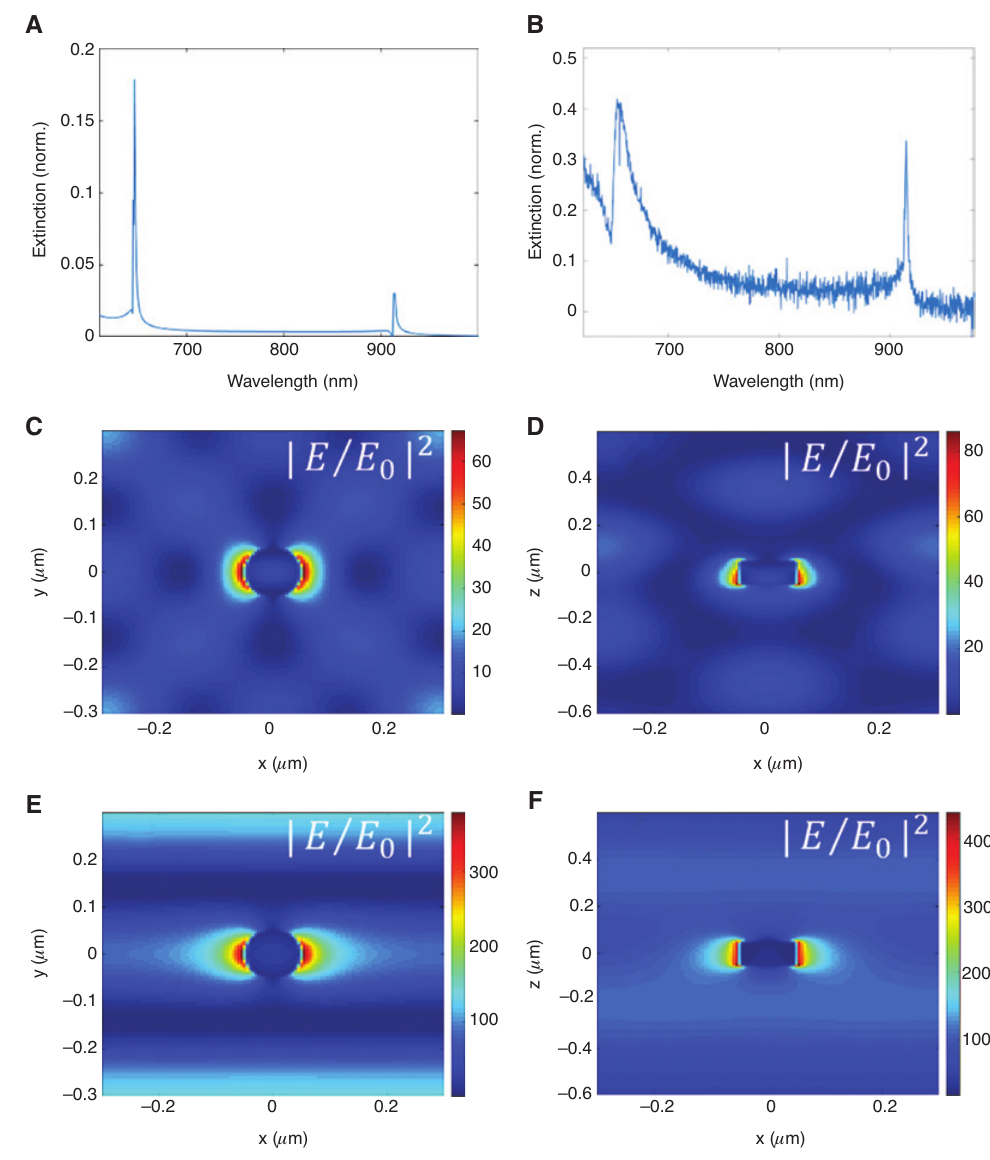
Figure 4: FDTD simulation results for amorphous silicon. (A) Simulated transmission spectrum and (B) measured spectra at k 646 nm crosscuts in the xy-plane (C) and xz-plane (D). Electric field intensity distribution at resonance at 913 nm crosscuts in the xy-plane (E) and xz-plane